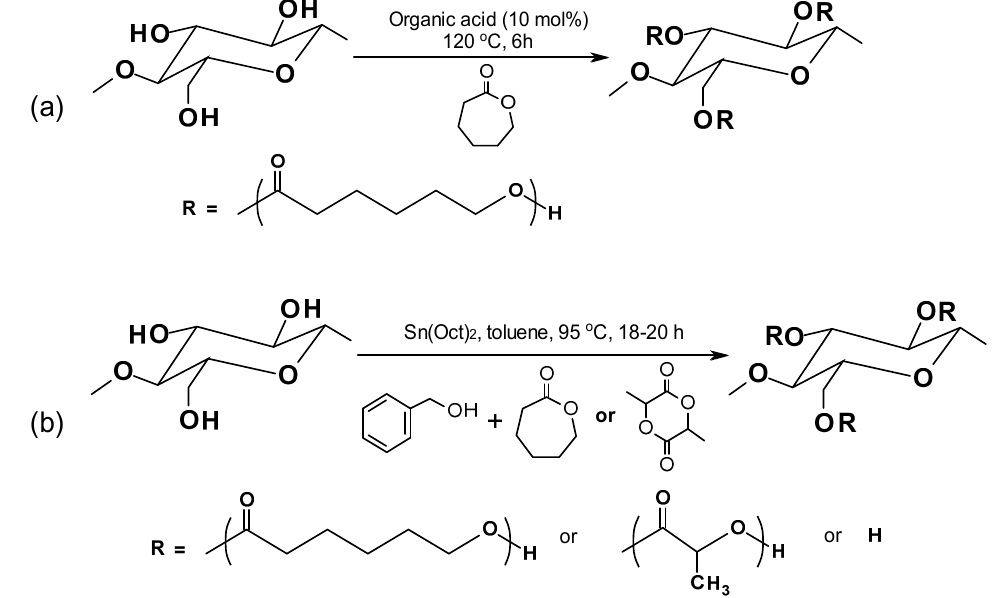
Figure 7. Organocatalytic ROP process of ( a ) cyclic ε -caprolactone and ( b ) cyclic ε -caprolactone or lactide with cellulose [132,133].